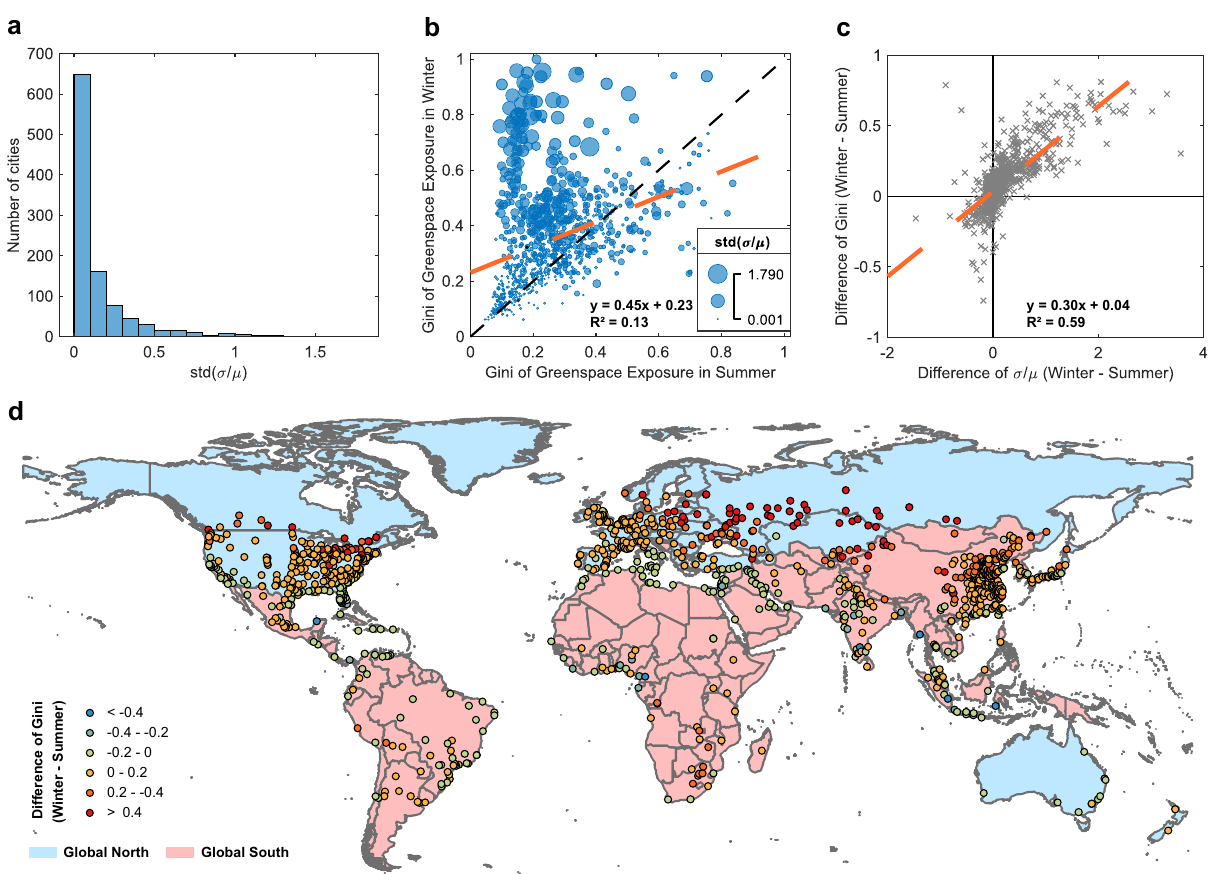
Fig. 3 | Seasonal change of greenspace exposure inequality for 1028 cities globally. a Histogram of seasonal greenspace exposure variation of each city, measured by the coef fi cient of spatiotemporal variation – std ( σ /u). b Difference between the Gini index of greenspace exposure in summer (x-axis) and winter (y-axis). The bubble size represents the magnitude of the spatial and seasonal greenspace exposure variation of each city, measured by std ( σ /u). Larger bubble